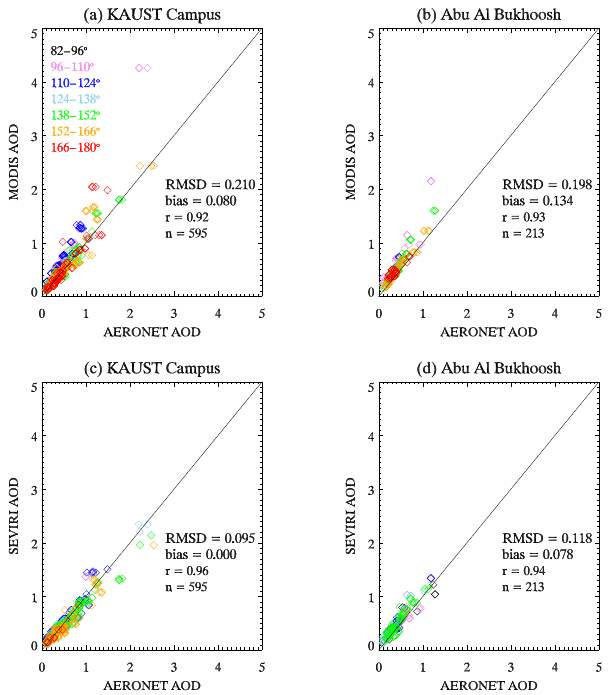
Figure 6. Satellite retrieval comparisons against L2 AERONET AODs measured at the KAUST campus (2012–2015) and Abu Al Bukhoosh (2006–2008) at a wavelength of 630nm. Colours repre- sent scattering angles to the satellite